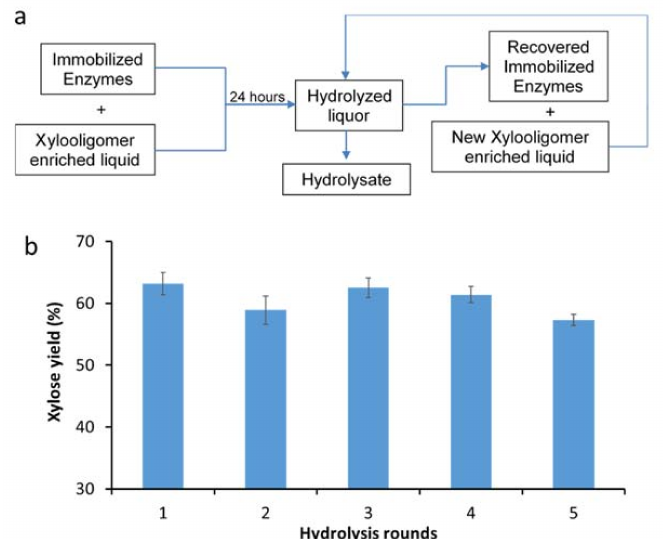
Figure 4. ( a ) Immobilized xylanase recycling protocol; ( b ) xylose yield from xylooligomer-enriched pre-treatment liquors over five rounds of recycling immobilized